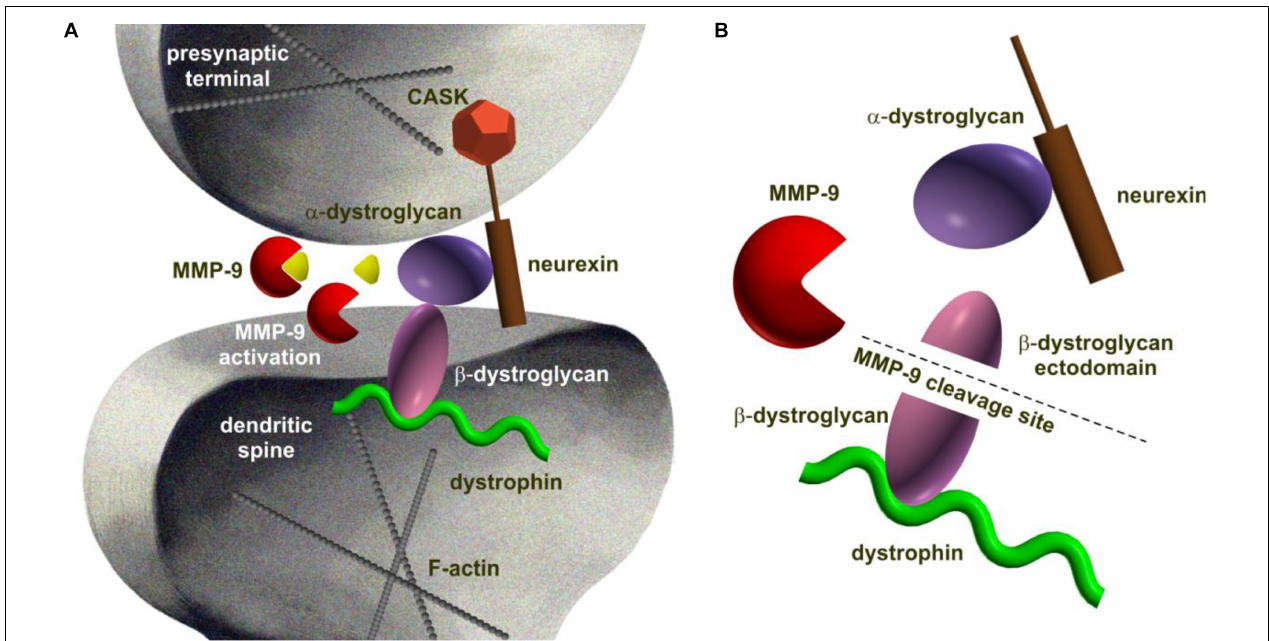
FIGURE 1 | Schematic representation of dystroglycan complex being processed by MMP-9 at the synapse as an example of proteolytic cleavage of trans-synaptic interaction. (A) Dystroglycan is an ubiquitous membrane protein associated to dystrophin. It is composed of α - and β -subunits. The α -dystroglycan is a highly glycosylated extracellular component, whereas transmembrane β -dystroglycan forms a bridge between α -subunit and the cytoskeleton. Like neuroligin, dystroglycan binds specifically to neurexins (Sugita et al., 2001). (B) MMP-9-mediated β -dystrogycan proteolysis occurs in response to synaptic activity (Michaluk et al., 2007). MMP-9 catalyzes the cleavage within the β -dystroglycan ectodomain producing a 30 kDa C-terminal fragment and an N-terminal region that is further processed (Bozzi et al., 2015). The consequences of β -dystroglycan cleavage are not known, however, a growing body of evidence suggests a functional role for the entire dystrophin-glycoprotein complex at central synapses and in their plasticity since deletion of this protein is critically associated with attenuated high frequency stimulation-induced long-term potentiation at certain synapses (Satz et al.,